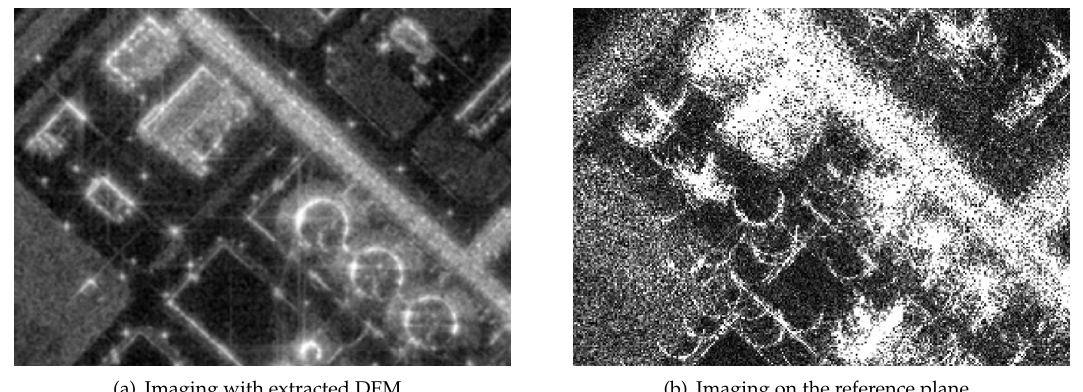
Figure 18. Region A: All-aperture image formed via magnitude accumulation of all the sub-aperture